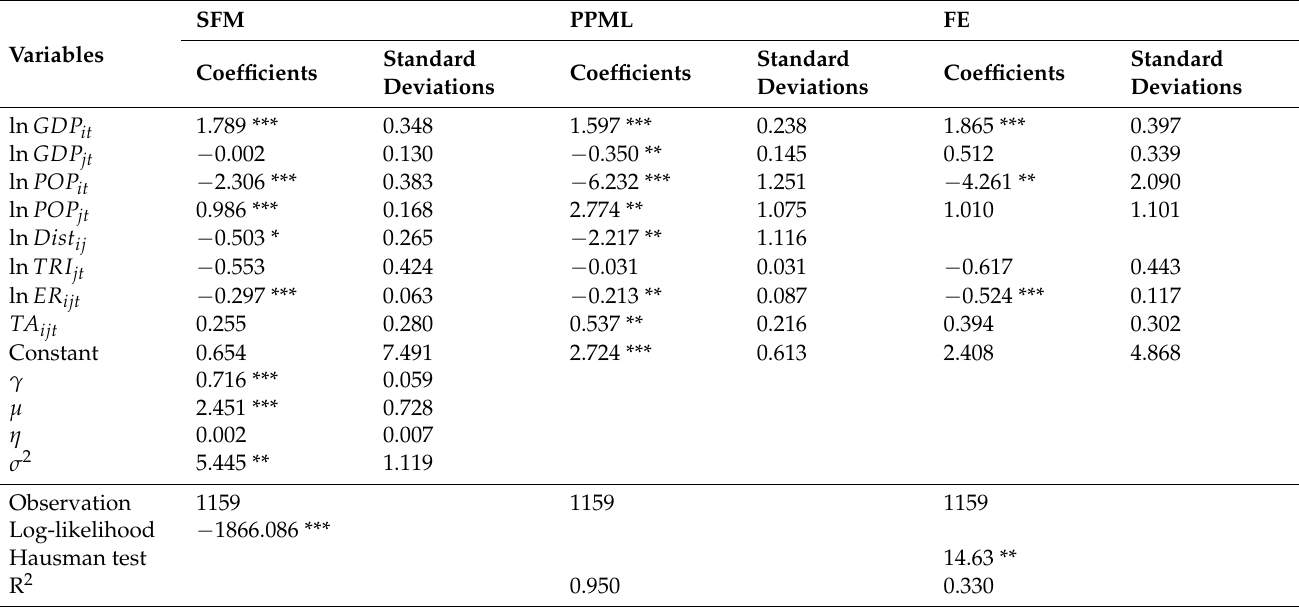
Table 3. Estimation Results for World Palm Oil